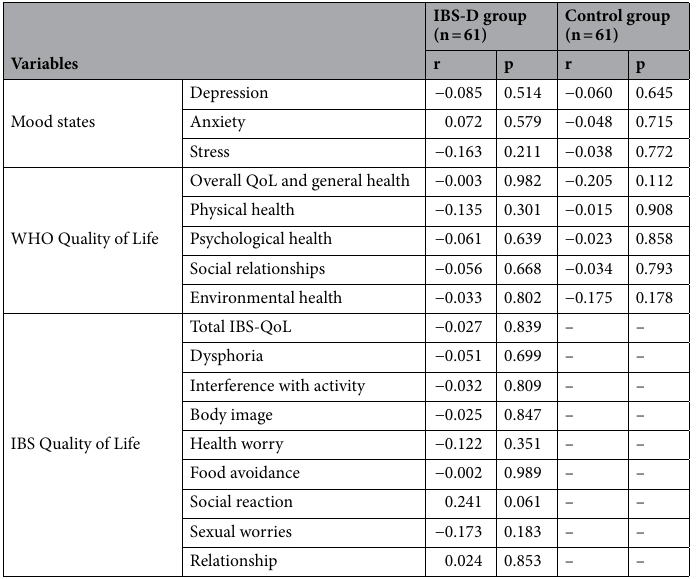
Table 4. Correlation between serum zinc levels with mood states and quality of life (QOL) scores. Data are presented as the Pearson’s correlation coefficient (r).